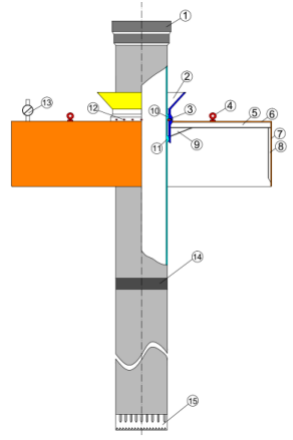
Figure 13. Conduit combination structure [This figure was modified with permission from ref [165]. Copyright 2018, Elsevier].